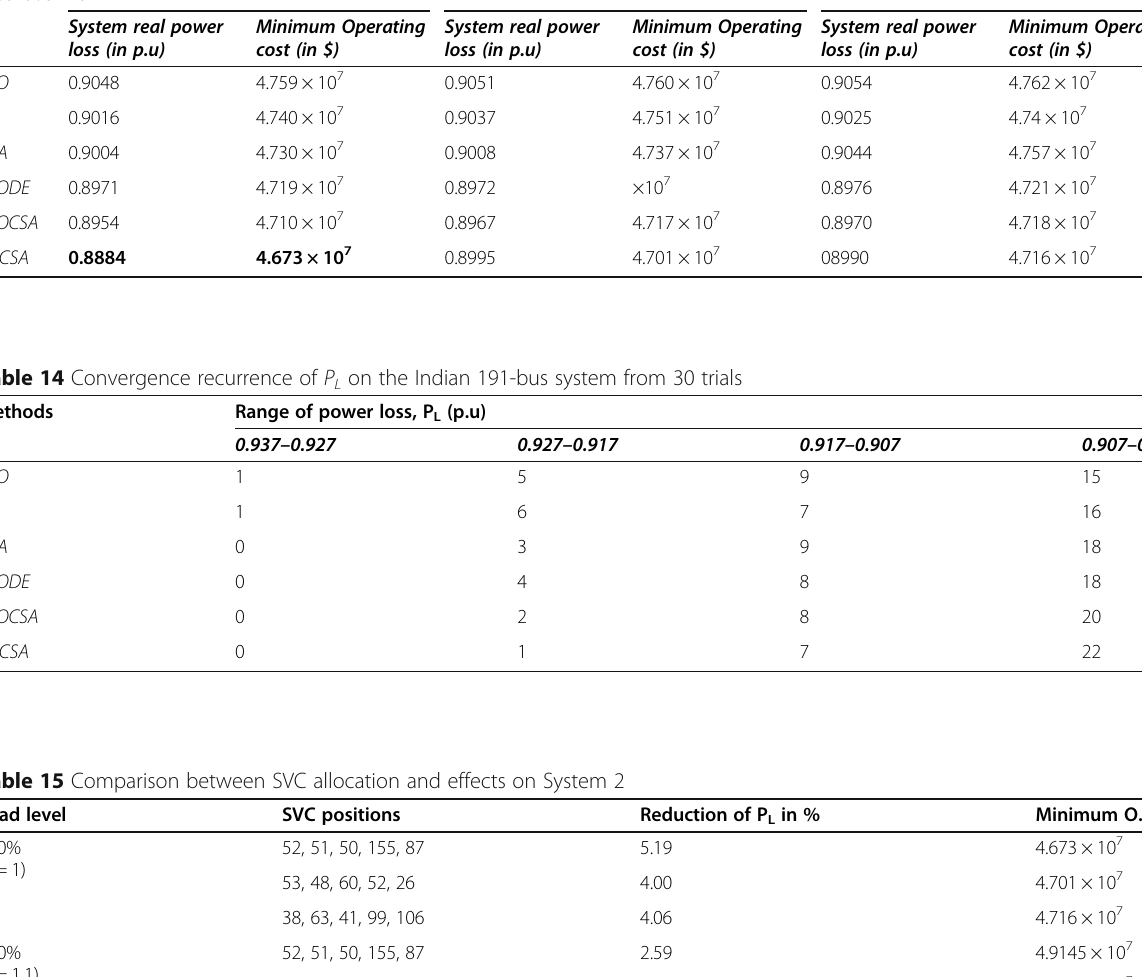
Table 13 Optimal performance for Indian 191-bus practical system of three different methods Methods LSA PFA MA System real power loss (in p.u)